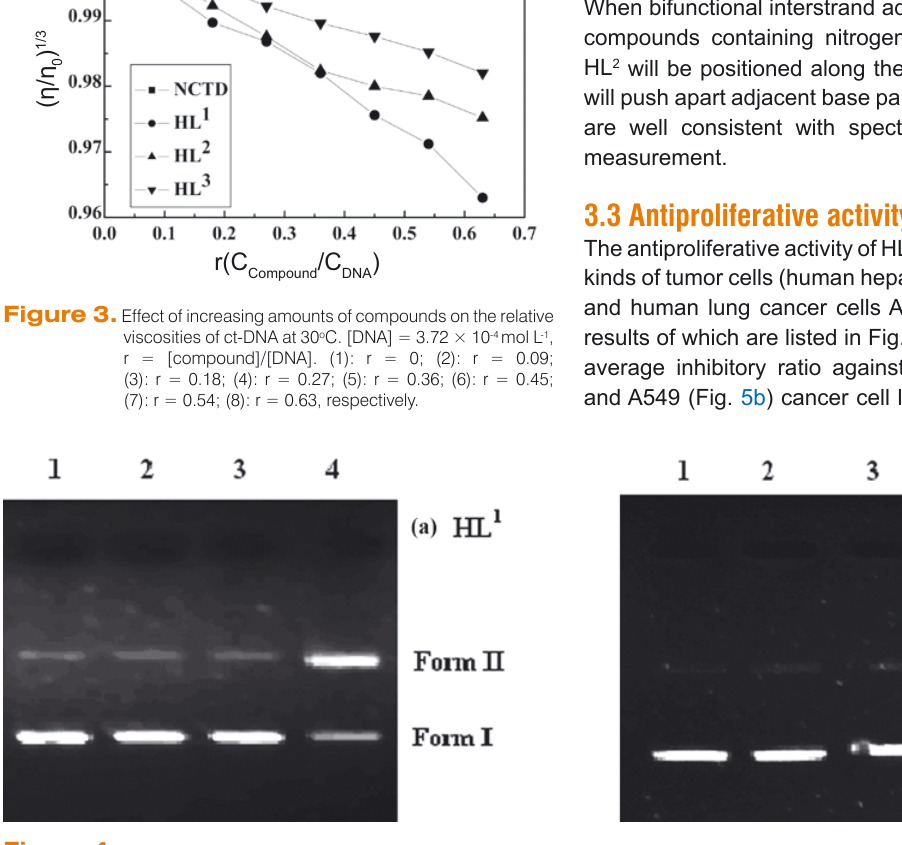
Figure 4. Electrophoretic separation of pBR322 DNA induced by HL 1 (a) and HL 2 (b), [DNA] = 3 μg mL -1 . lane 1: DNA alone; lane 2: DNA+compound (100 μM); lane 3: DNA+compound (200 μM), lane 4: DNA+ compound (400 μM).